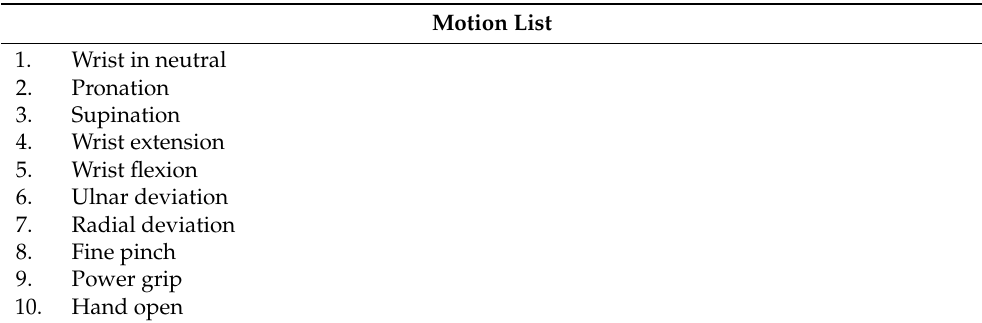
Table 1. List of 10 motions of Angeles EMG dataset [36].